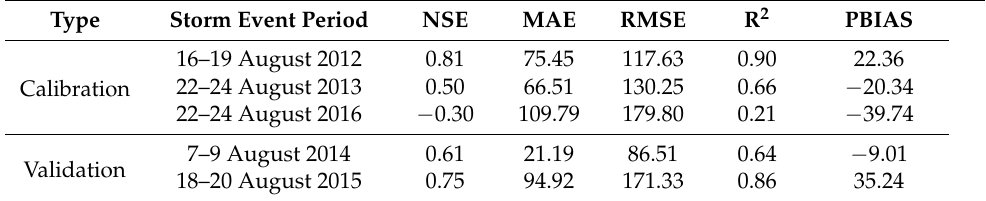
Table 3. Major parameter indices after calibration and validation with optimized parameter values.